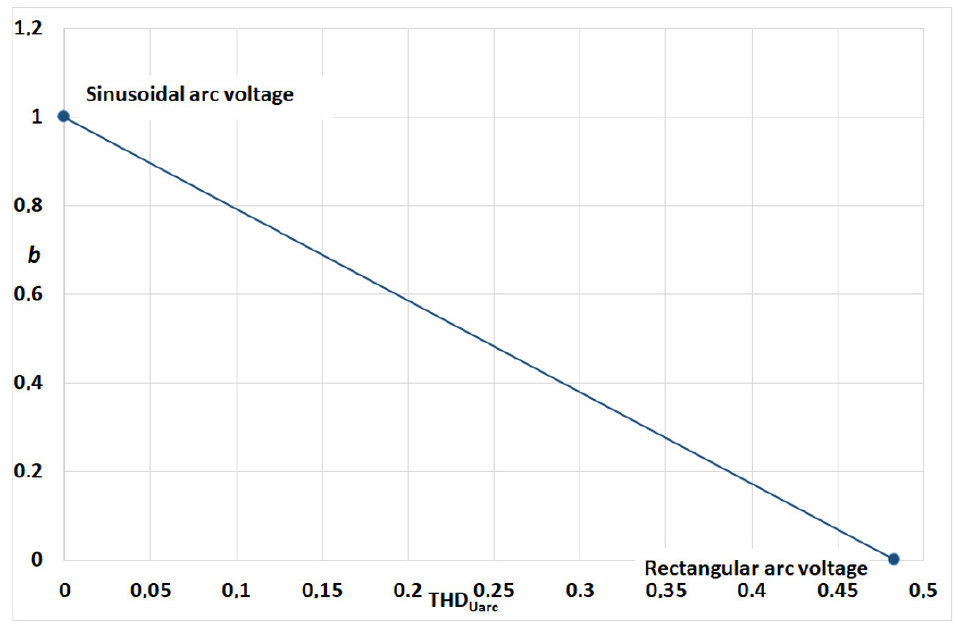
Figure 21. Dependence of changes in the value of the arc voltage distortion coefficient on the value of parameter b .